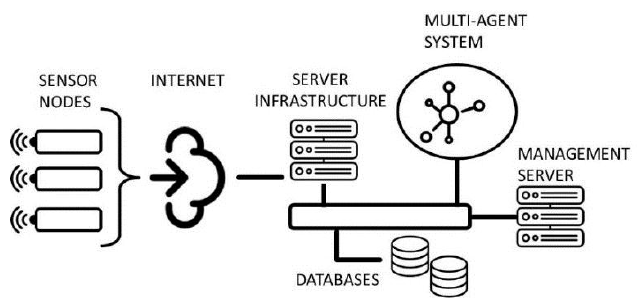
Figure 2. General overview of the sound monitoring sensor network architecture.